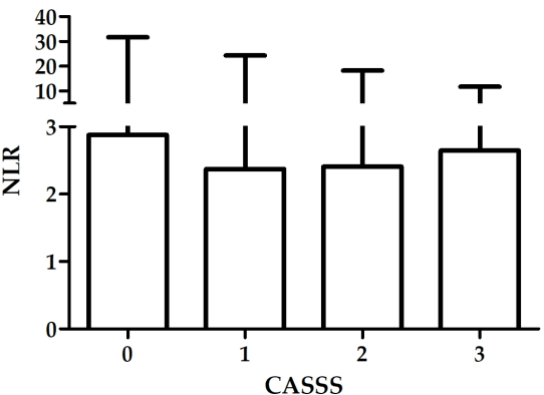
Figure 2. Association between NLR and severity of CAD in the whole group, box—median, whiskers—range. Table 3. NLR in patients with different stages of CAD.